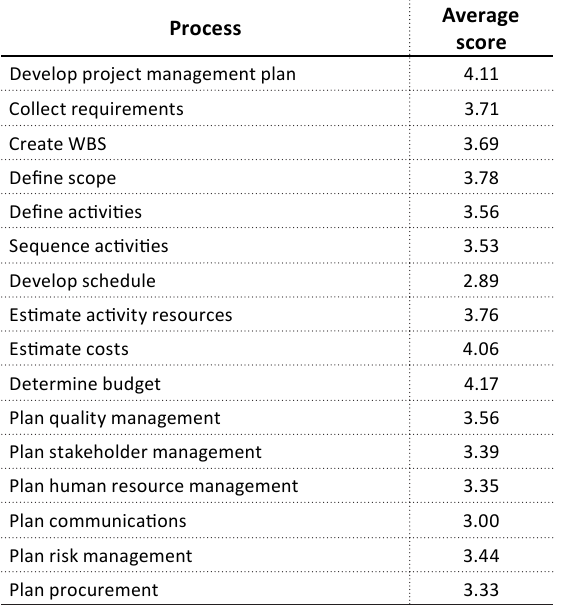
Table 2. Frequency of planning processes at KE Process